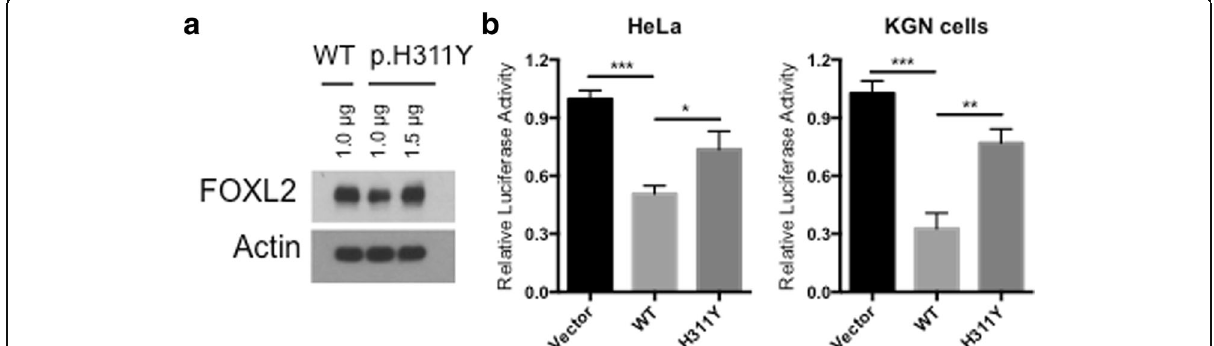
Fig. 4 Transcriptional repression activity of WT and p.H311Y mutant FOXL2 . a . Expression level of WT and p.H311Y mutant FOXL2. b . Transcriptional repression activity of WT and p.H311Y mutant FOXL2 as measured by luciferase assay in both HeLa and KGN cells. Luciferase vector driven by the StAR promoter was cotransfected with empty vector, WT or p.H311Y mutant FOXL2 plasmids, followed by luciferase activity measurement. * p < 0.05, ** p <